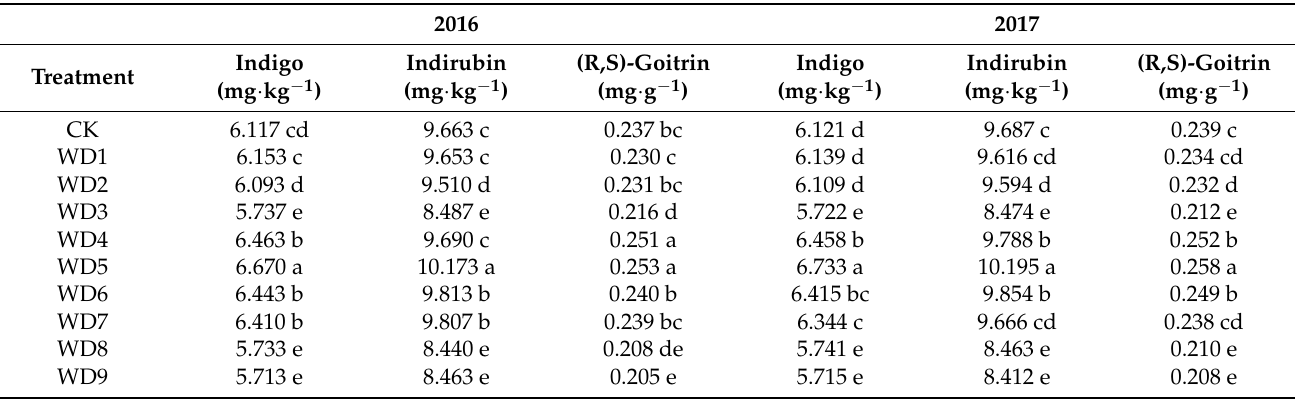
Table 4. Impacts of different water-deficit treatments on Isatis indigotica quality after the final ripening and